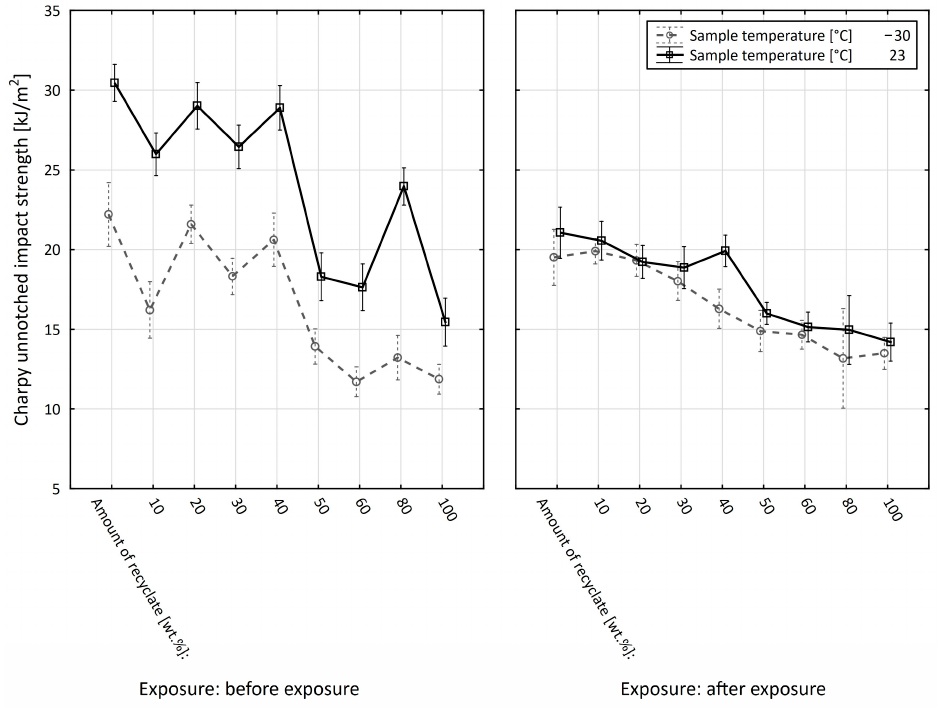
Figure 13. Dependence of the mutual interaction of the sample temperature and the exposure of the sample on the value of the unnotched impact strength of PPA .